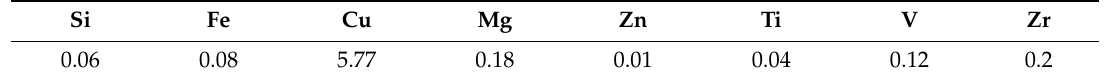
Table 1. The chemical composition of AA2519 aluminum alloy